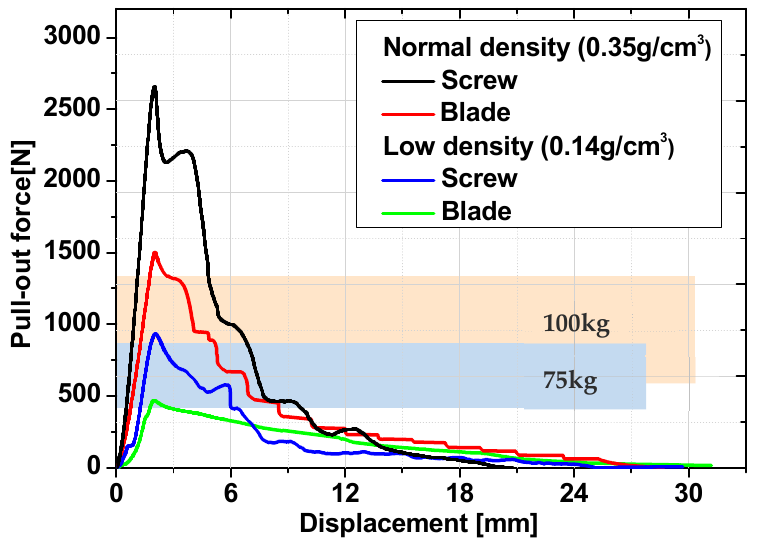
Figure 13. Relation between contact force on femoral head and pull-out force along insertion direc- tion.